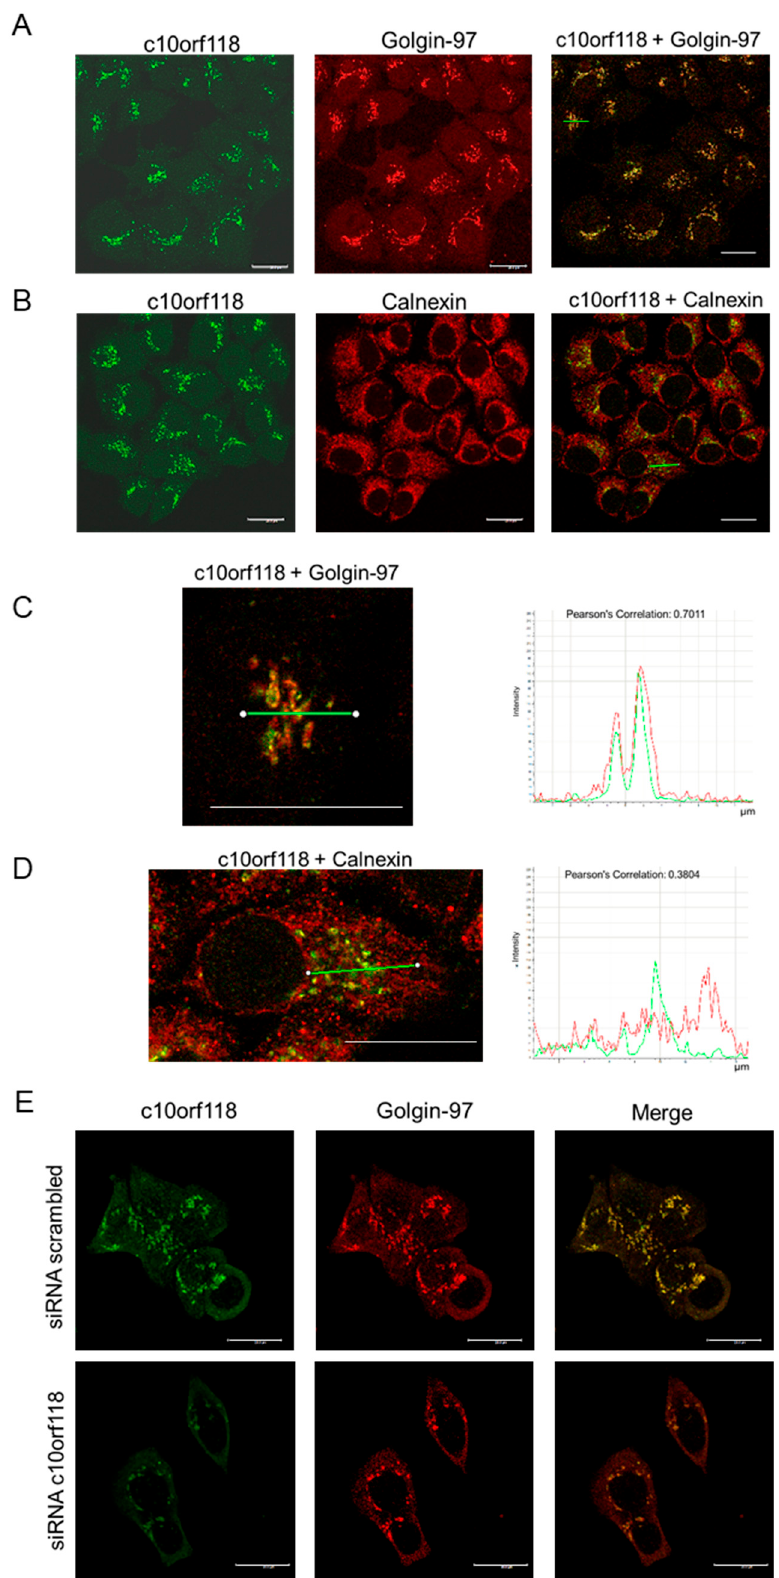
Figure 3. Endogenous c10orf118 localizes in the Golgi apparatus in MCF-7 cells. ( A ) Confocal microscopy images of MCF-7 cells stained for c10orf118 (green) and Golgin-97 (red), a Golgi apparatus marker. ( B ) Confocal microscopy images of MCF-7 cells stained for c10orf118 (green) and calnexin (red), a specific endoplasmic reticulum marker. ( C ) Line-scan of the staining performed in the